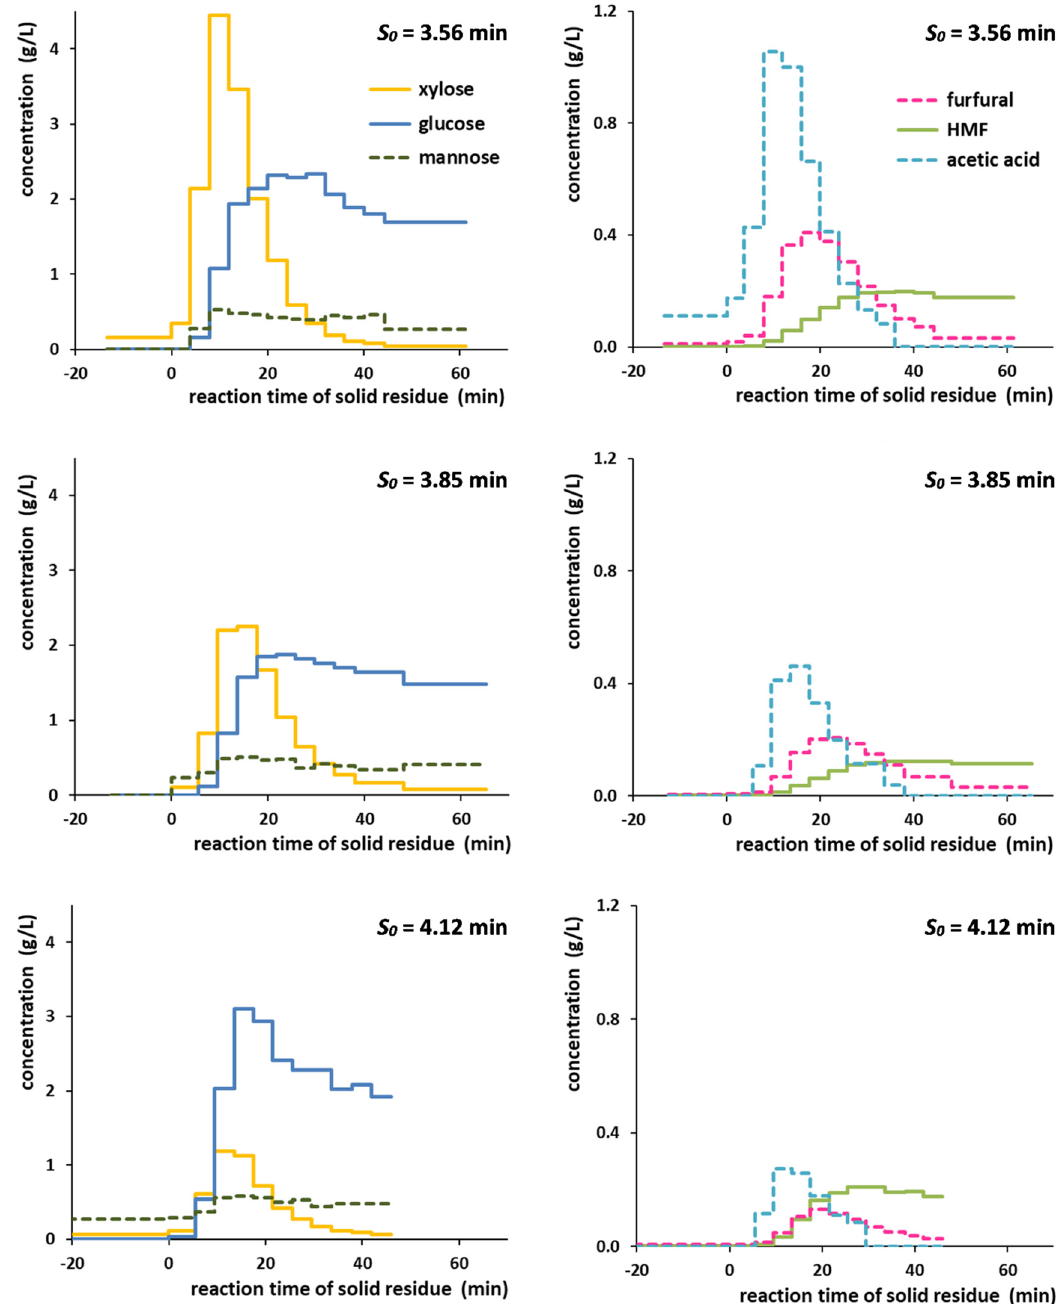
Figure 4. Formation of monosaccharides ( left ) as well as furfural, hydroxymethylfurfural and acetic acid ( right ) during the hydrolysis of 15.0 g steam-exploded residue at different severity parameters S 0 , hydrolysis with 0.05 mol/L sulfuric acid at 15 mL/min flow at 180 °C, t = 0 min marks the beginning of acid hydrolysis.